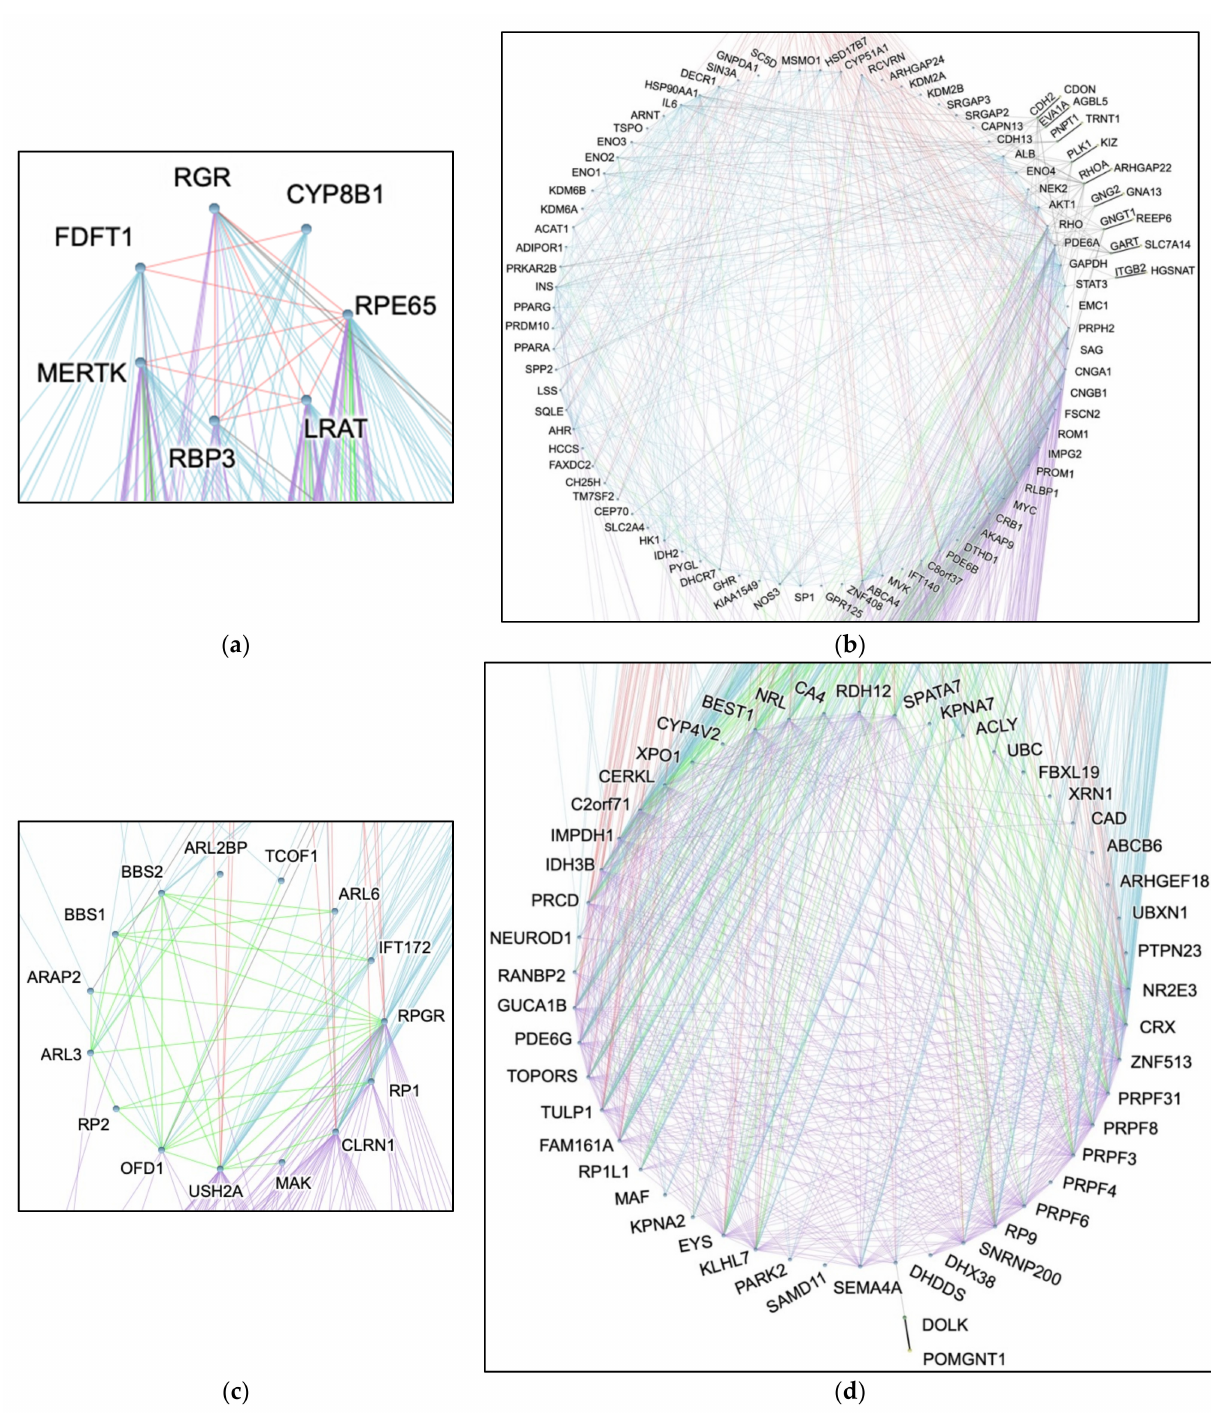
Figure 3. The Annotated Individual View of Complex Network of Genes Based on the Protein–Protein Interactions from the STRING v11 Database. Each group is zoomed in for a closer inspection of the relationship portrayed in Figure 2. Since PPIs are bidirectional, each edge in Figure 2 can be annotated in two different colors. In this panel, each figure is annotated with each respective group being the origin node (from: origin node, connects to: Group 1—red; Group 2—blue; Group 3—green; Group 4—purple). ( a ) Expanded view of Group 1; ( b ) expanded view of Group 2; ( c ) expanded view of Group 3; ( d ) expanded view of Group